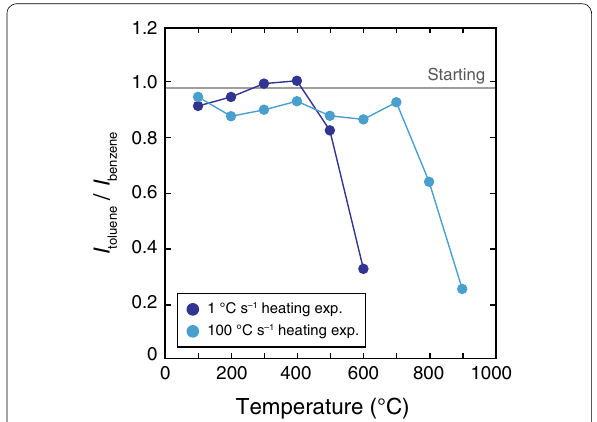
Fig. 6 Temperature dependence of the I toluene / I benzene ratios of the analyzed CM. The ratios of the products heated to and to 1000 °C at 100 °C s − 1 are not available owing to extinction of the toluene and benzene peaks. exp .